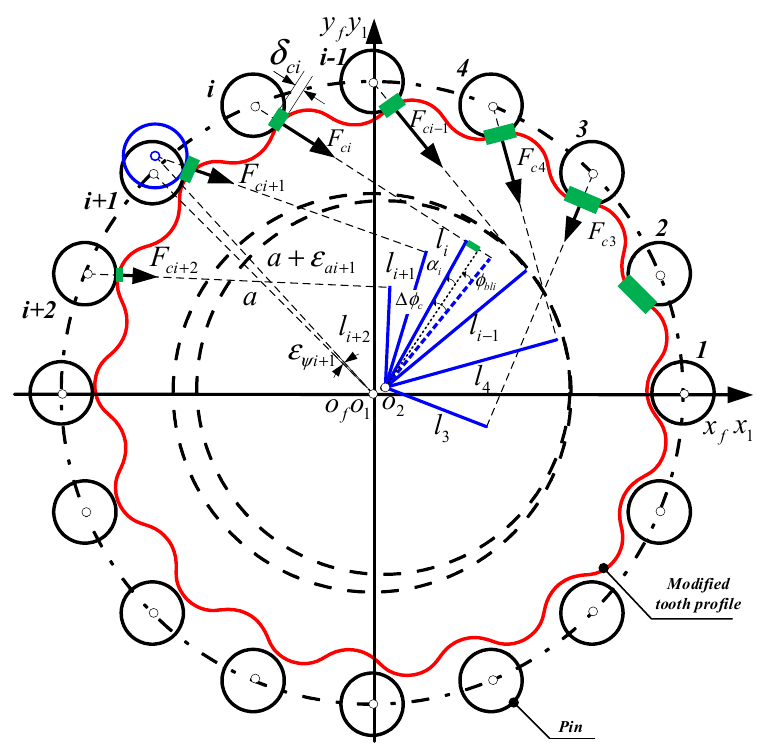
Figure 6. Compatibility and equilibrium conditions.